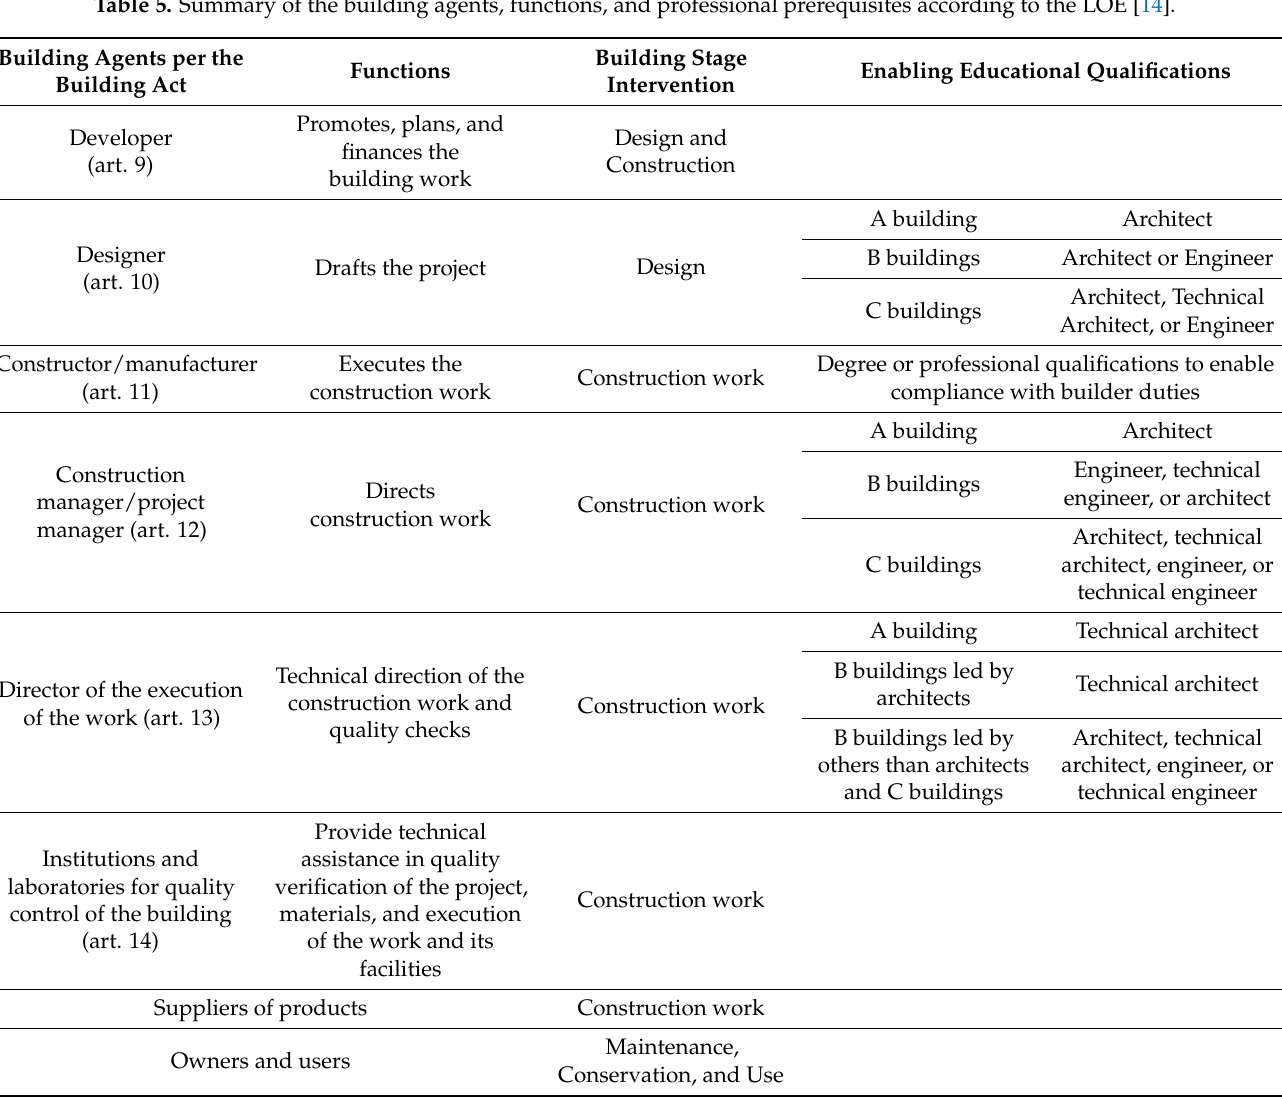
Table 4. Type of buildings according to the LOE. Source: LOE. Translated by the authors. Group Use A Administrative, health, religious, residential in all its forms, educational and cultural. B